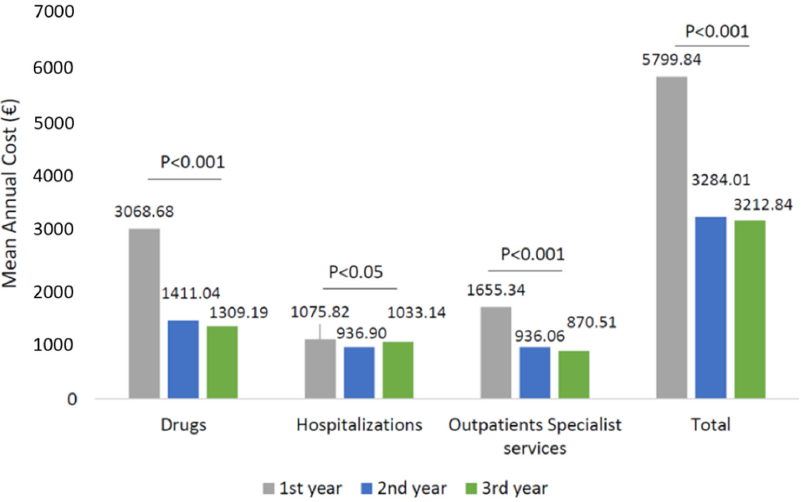
Figure 3. Health care-related costs during the follow-up among patients in the wAMD-cohort.